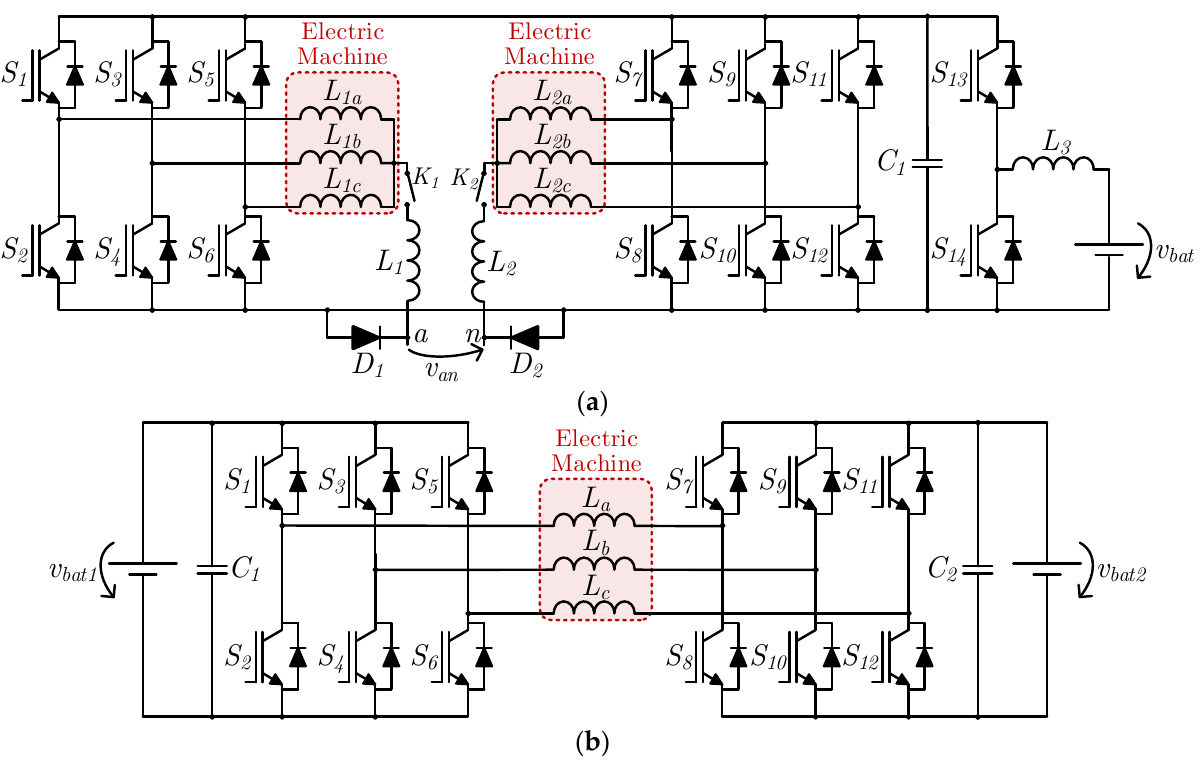
Figure 16. EV IBCs based on two traction converters proposed in 2015 by: ( a ) D. G. Woo et al. [33]; ( b ) J. Hong et al. [34].